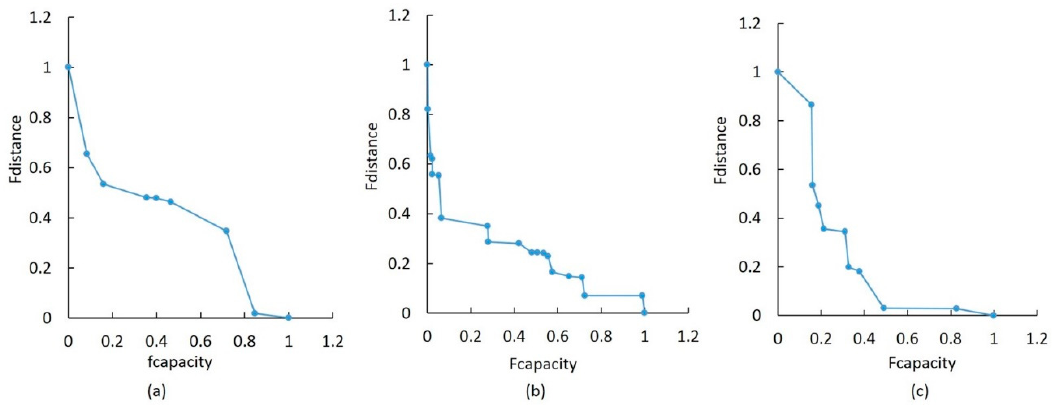
ISPRS Int. J. Geo-Inf. 2019 , 8 , x FOR PEER REVIEW Figure 13. The Pareto-optimal fronts generated by: ( a ) the standard MOABC; ( b ) NSGA-II; and ( c ) the proposed MOABC. The standardized minimum fitness values of both capacity and distance function.